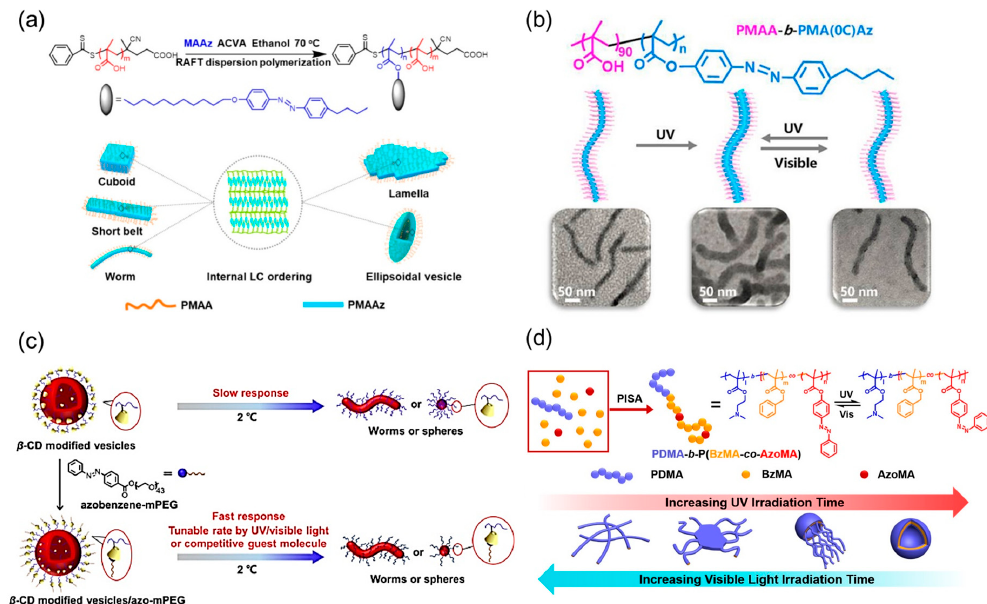
Figure 14. Schematic representation of Azo-polymer assemblies and morphological transition constructed by PISA strategy. (For ( a – d ), Reprinted with permission from [232–235]; Copyright (2018,